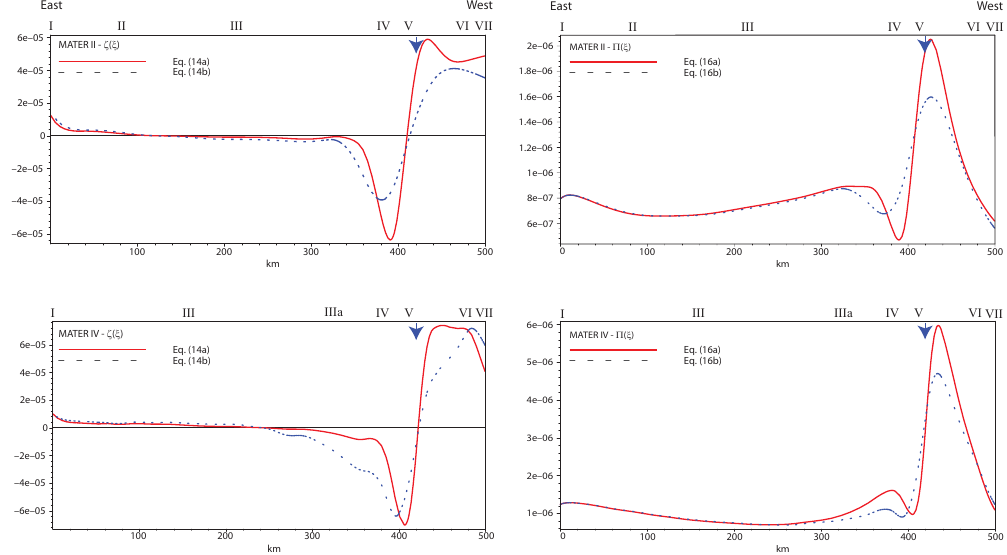
Figure 6. Analytic profiles for ζ (s–1) and (cid:53) (m − 1 s − 1 ) along ξ (km) as obtained from Eqs. (13) and (15), respectively. The dashed lines E(u − u 2 ) ≈ 0, i.e., Eq. (14b). Position of the transects is also shown (see Figs. 3 and 4) for indicate approximate solutions for ζ (cid:28) f and 1 h MATER II and MATER IV cruises. The arrows show the position of the